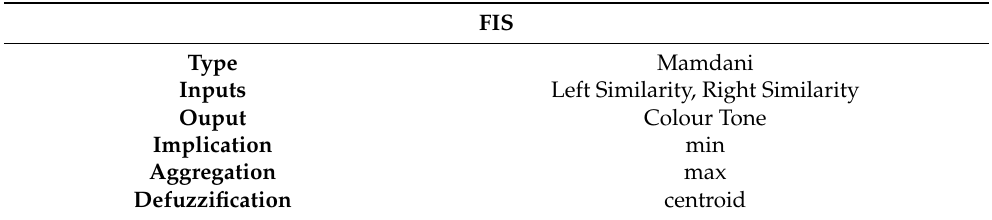
Table 2. A summary of the FIS that adjusted the colour tone of each pixel and we first implemented in [17].